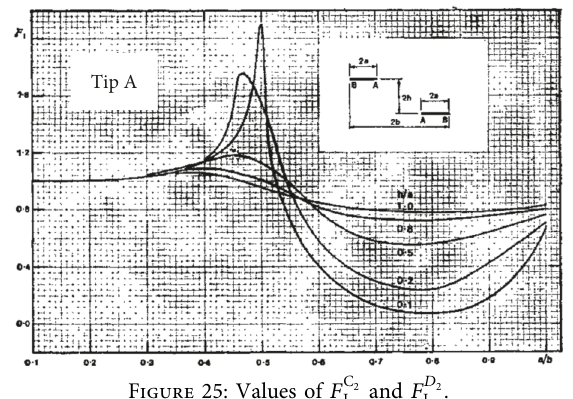
Figure 25: Values of F C 2